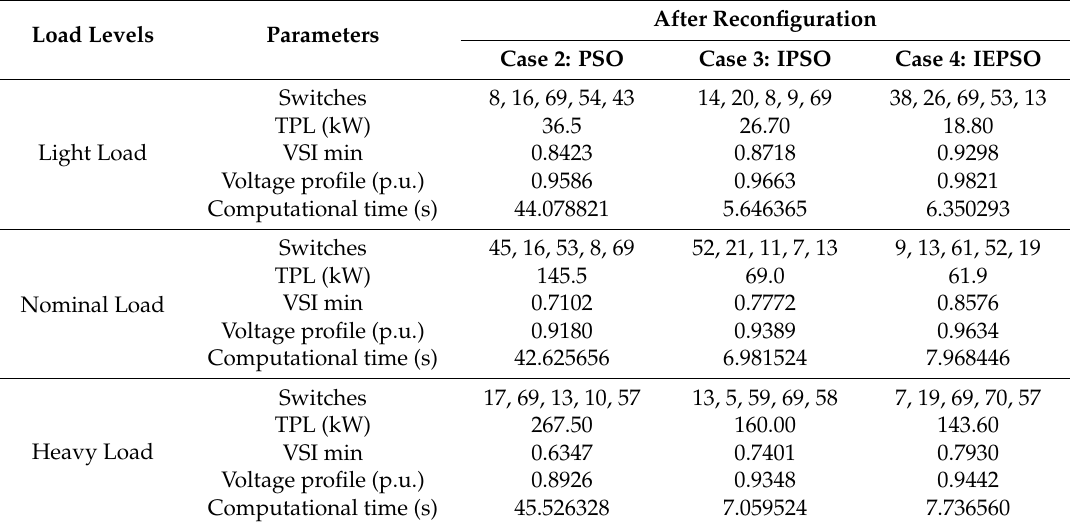
Table 6. The performances of PSO, IPSO and IEPSO for DNR implementation in 69-bus radial distribution system.